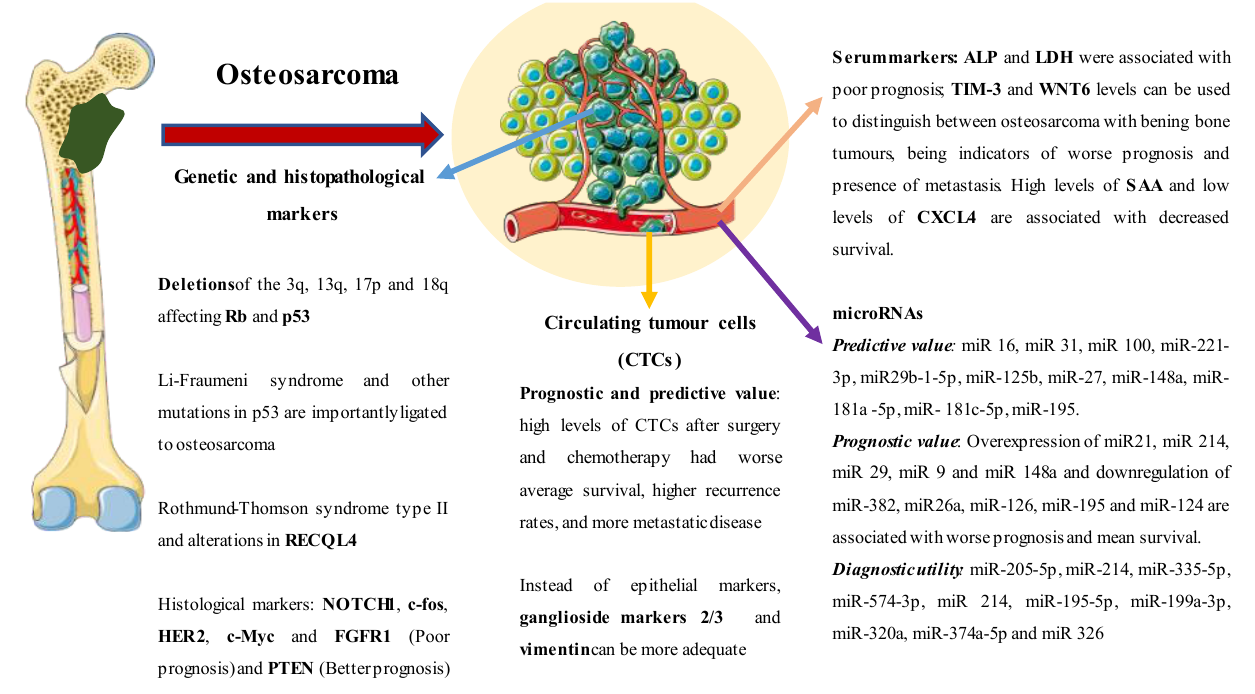
Figure 1. A global perspective on the available biomarkers studied in osteosarcoma.